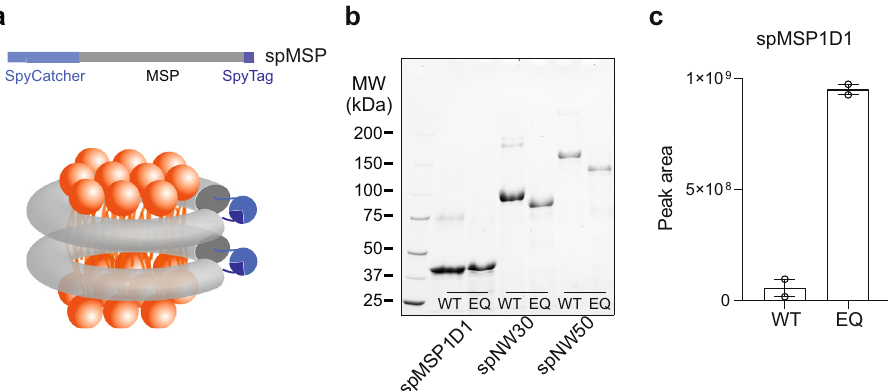
Fig. 1 Circularization of MSPs via the SpyCatcher-SpyTag. a The SpyCatcher (sapphire blue) and SpyTag (navy blue) were appended to the N- and C-termini of MSPs for spontaneous circularization of MSPs in cells (upper). Illustration of the circularized nanodiscs by the SpyCatcher-SpyTag (bottom). b Representative SDS-PAGE of circularized (WT) and non-circularized (EQ) MSPs. n = 4 independent experiments. c Quanti fi cation of the unreacted peptide in the WT and EQ mutant of spMSP1D1 using mass spectrometry. Data are shown as mean ± s.d., n = 2 independent experiments. Source Data are available as a source data fi